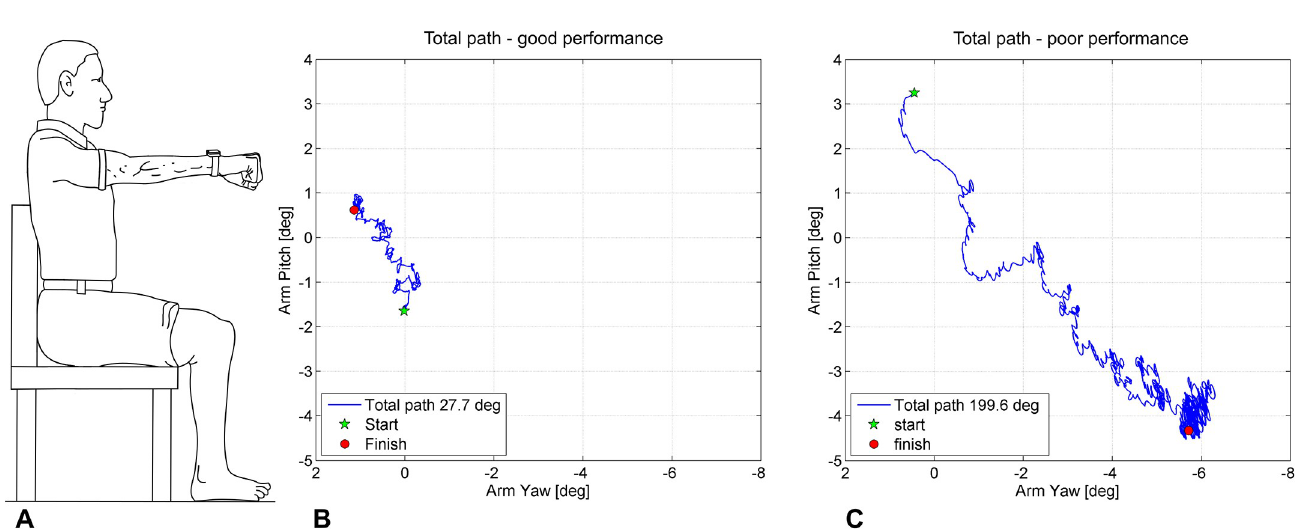
Fig 7. Arm stability. (A) The participant raised their straight arm until it was parallel to the floor while holding a small 250 g weight in their hand. The participant was instructed to hold the arm as steady and still as possible for 30 seconds. Total path (˚) was recorded by an inertial measurement unit, which was attached to the wrist. (B) Total path (27.7˚) from a 30-year-old female study participant in the weight eyes open (WEO) test condition, projected onto a yaw/pitch axis for visualisation. (C) Total path (199.6˚) from a 95-year-old female study participant in the WEO test